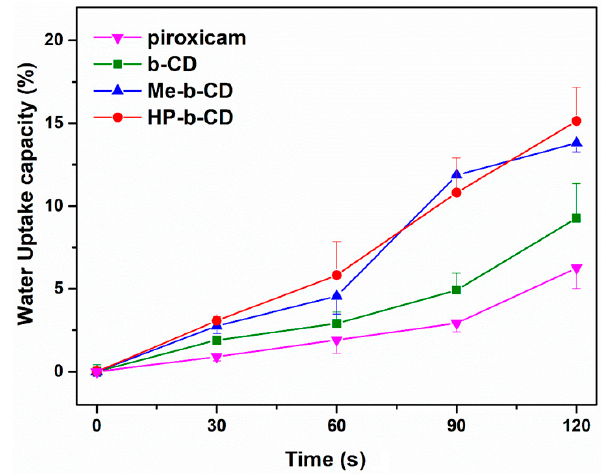
Figure 1. The water uptake capacity of tablets ( n = 3).